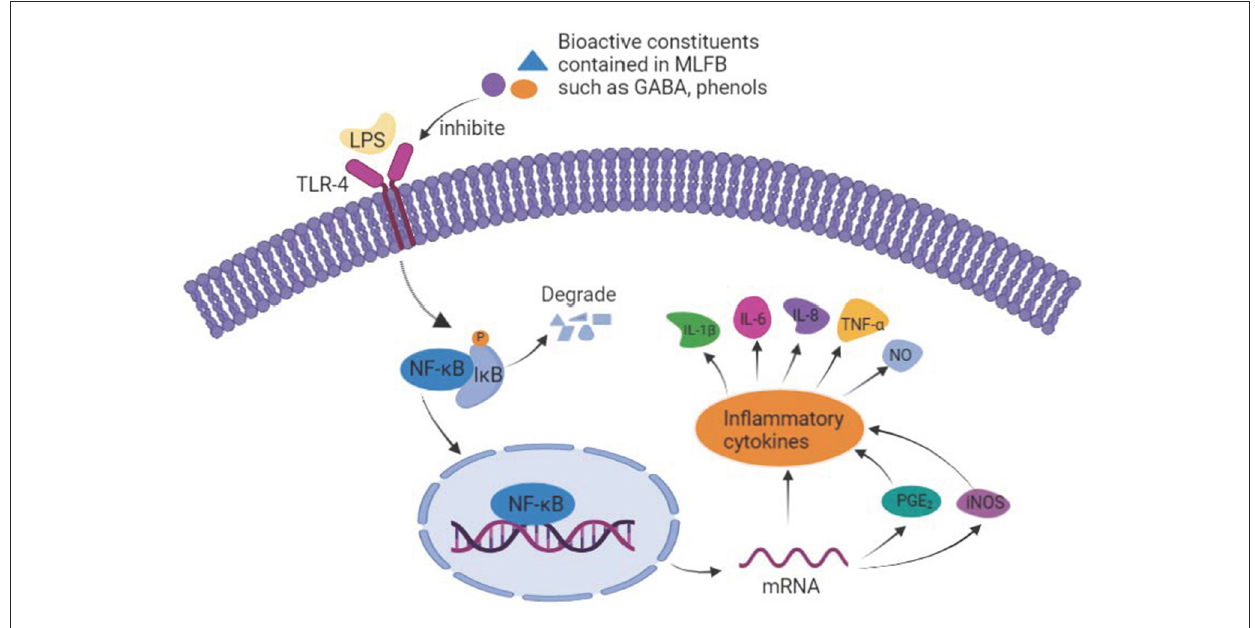
FIGURE7 The underlying anti-inflammatory mechanism of